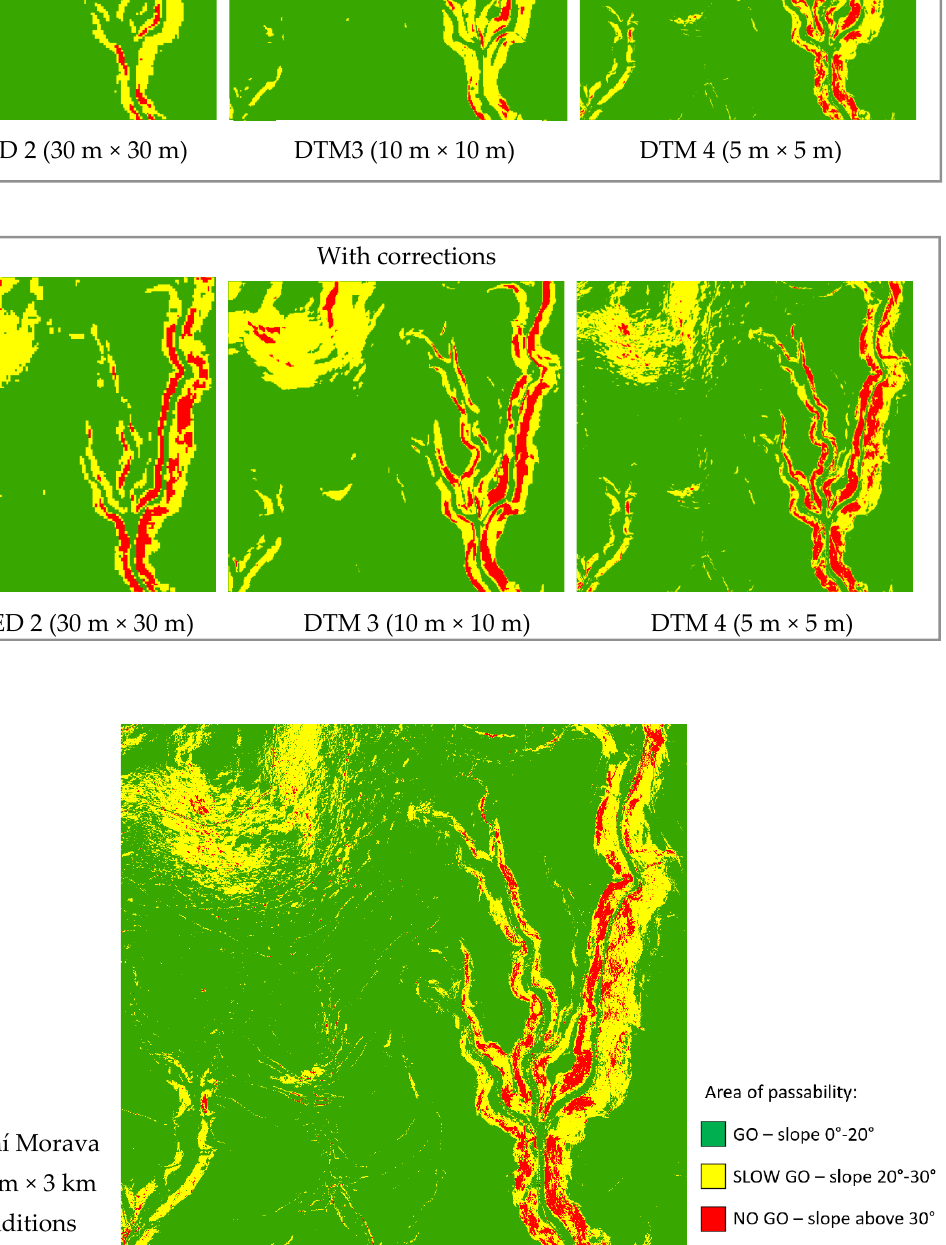
Figure 9. The map comparison of the CCM analysis with different elevation models (DTM 5, DTM 4, DTM 3, DTED 2) without slope corrections and with slope corrections. The slope corrections en- abled accurate results of CCM analysis for lower-detail models. DTM 5 (1 m × 1 m) served as the reference